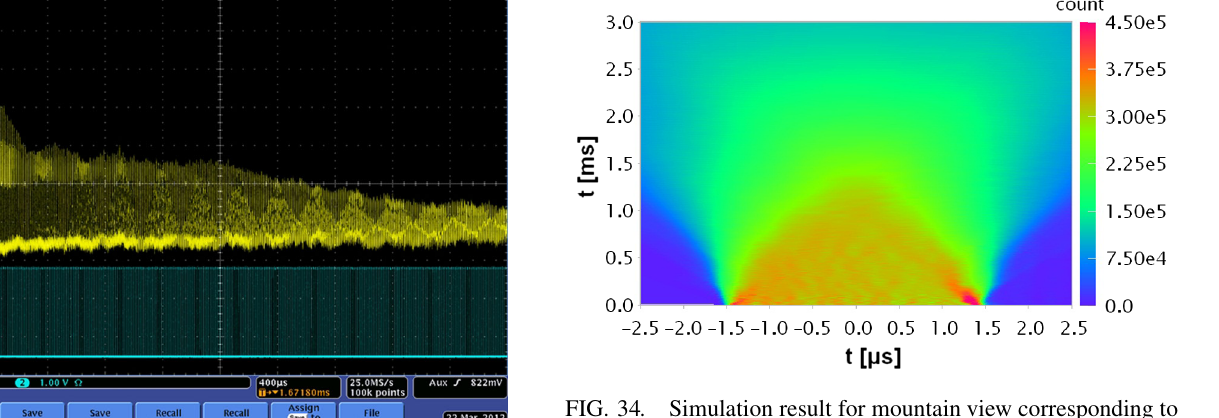
FIG. 34. Simulation result for mountain view corresponding to the 50 (cid:1) A beam bunch.